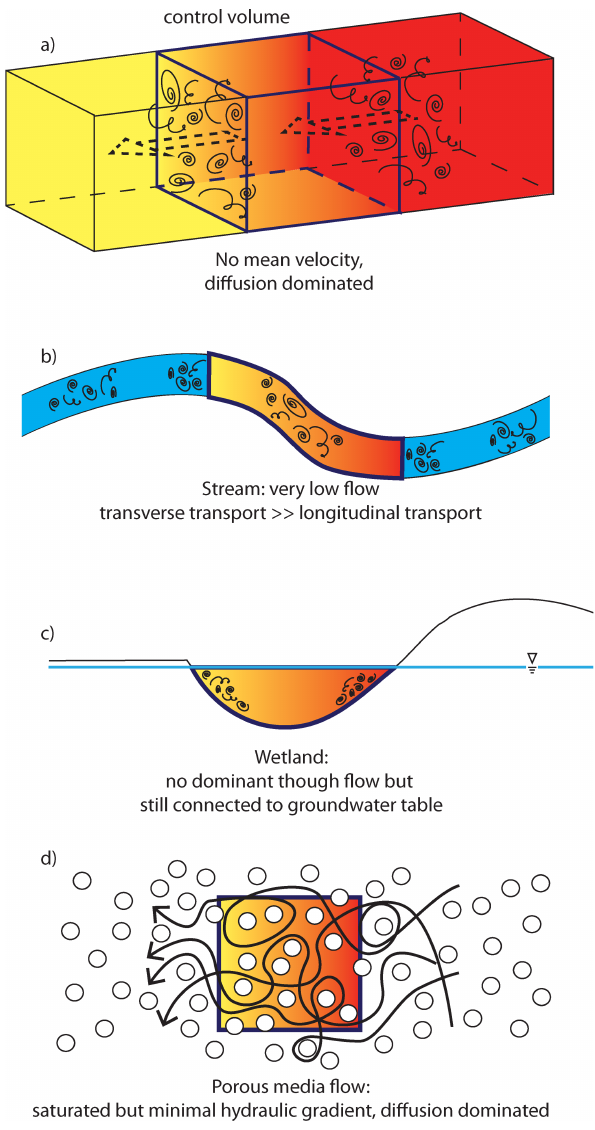
Fig. 3. Regime II: (a) transport and fluxes of chemical B across hydrologically or hydraulically connected elements are dominated by diffusion. Examples of this regime are a river under very low flow conditions, where for example transverse transport exceeds longitudinal transport (b) , a wetland at equilibrium with the local groundwater (c) and porous media flow under minimal hydraulic gradient (d)